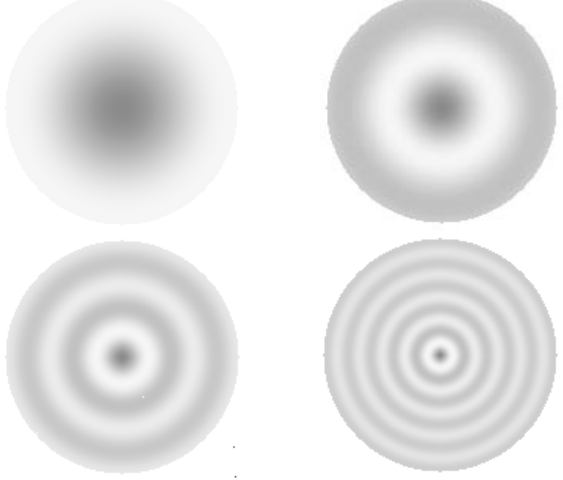
Figura 1 . Exemplos de estímulos de freqüências radiais (acima, da esquer- da para a direita, 0,25 e 0,5 cpg e embaixo, da esquerda para direita, 1 e 2 cpg). Estímulos originalmente calibrados para serem vistos a 150 cm de